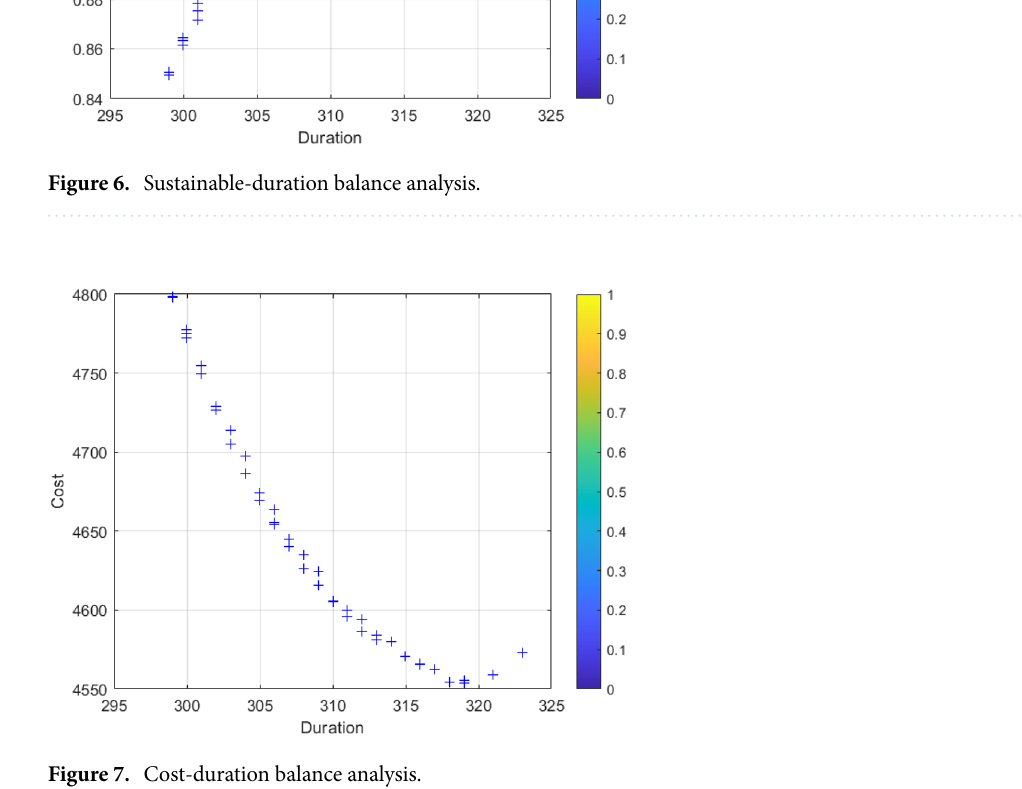
Figure 7. Cost-duration balance